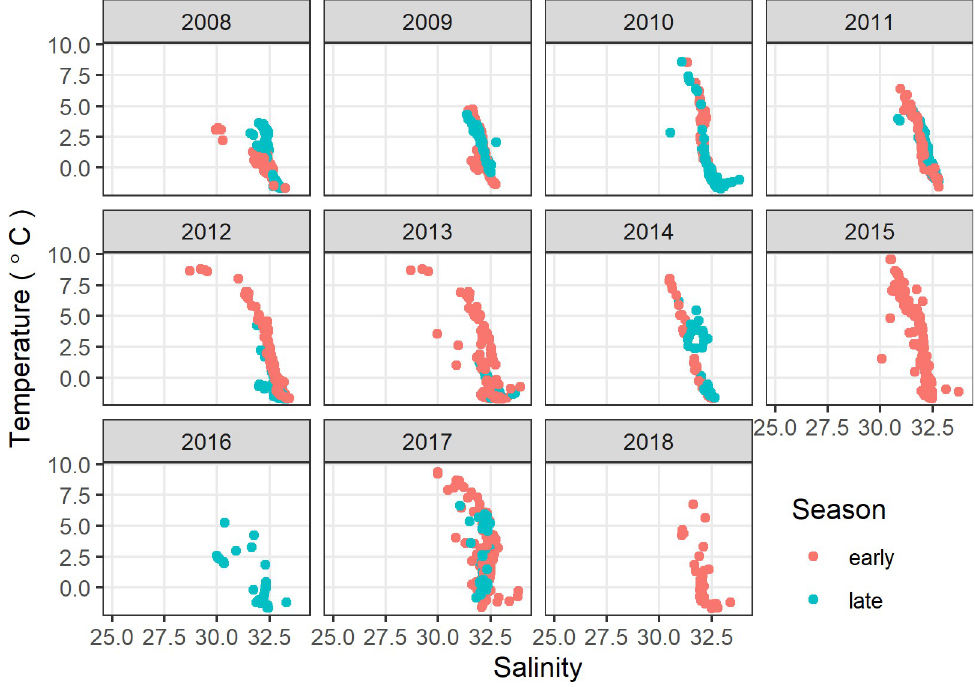
Fig 3. Temperature and salinity of water in bottom 10 m of water column, northeastern Chukchi Sea. Early summer was 13 Aug–6 September and late summer was 7 September–2 October.